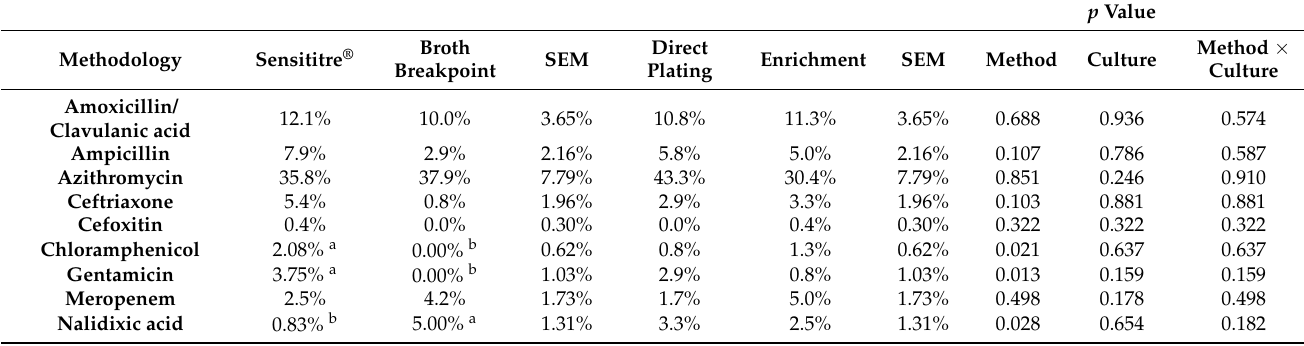
Table 6. Effects of antimicrobial resistance methodology and bacteria culturing method on Salmonella antimicrobial resistance patterns in trial two.